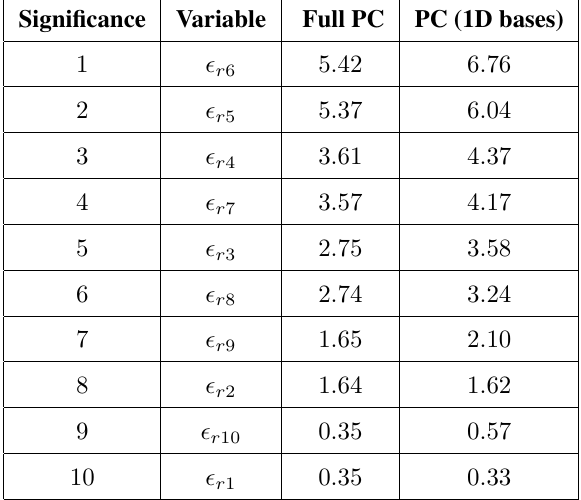
Table 1: Estimated average partial variances ( × 1000 ) for the stack-dielectric problem.